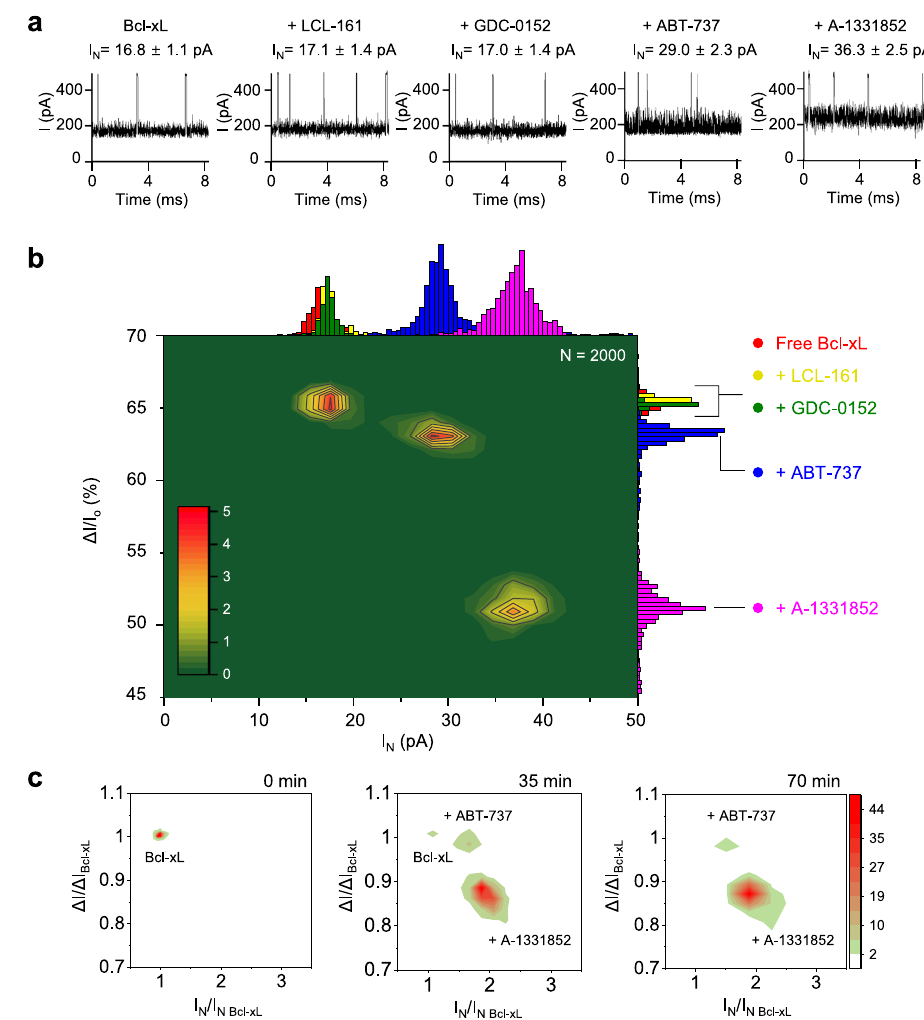
Fig. 4 | Single-molecule detection of interactions between Bcl-xL and small- moleculedrugsusingYaxABnanopores.a Representativeioniccurrenttracesfor Bcl-xL in the absence or presence of non-binders (LCL-161 and GDC-0152) and strong binders (ABT-737 and A-1331852). Each small-molecule was premixed with Bcl-xL at a 1:10 molar ratio and then added to the cis chamber. Nanopore events were recorded in 1M KCl at pH 7.5 with +100mV applied voltage on the cis side. Values of current blockade ( Δ I/I o ) and current noise (I N ) were obtained after addi- tional fi ltrationusinga100HzBessel(8-pole) fi lter. b 2Ddensitycontourplotof Δ I/